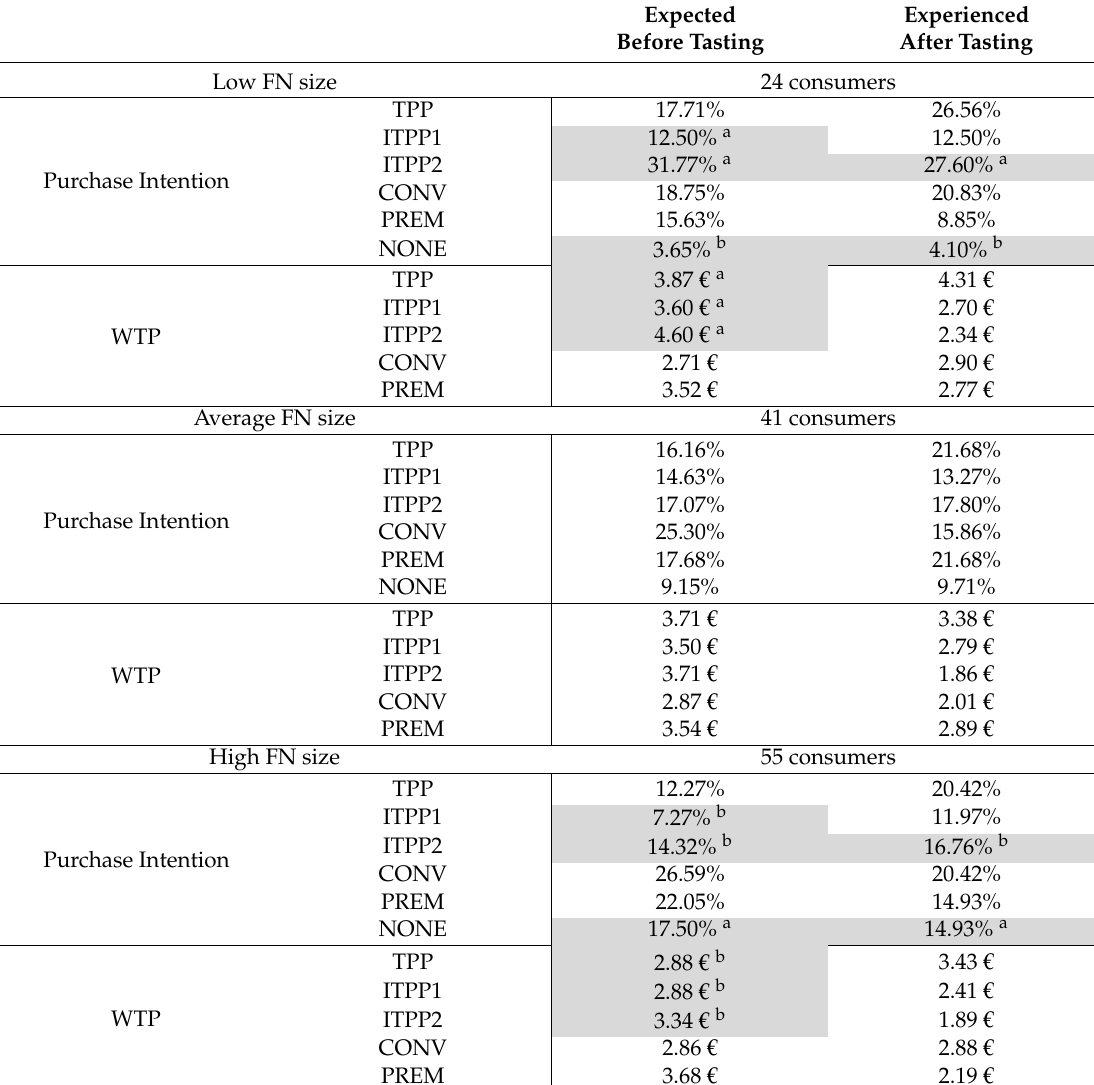
Table 7. Food neophobia and the non-hypothetical WTP and